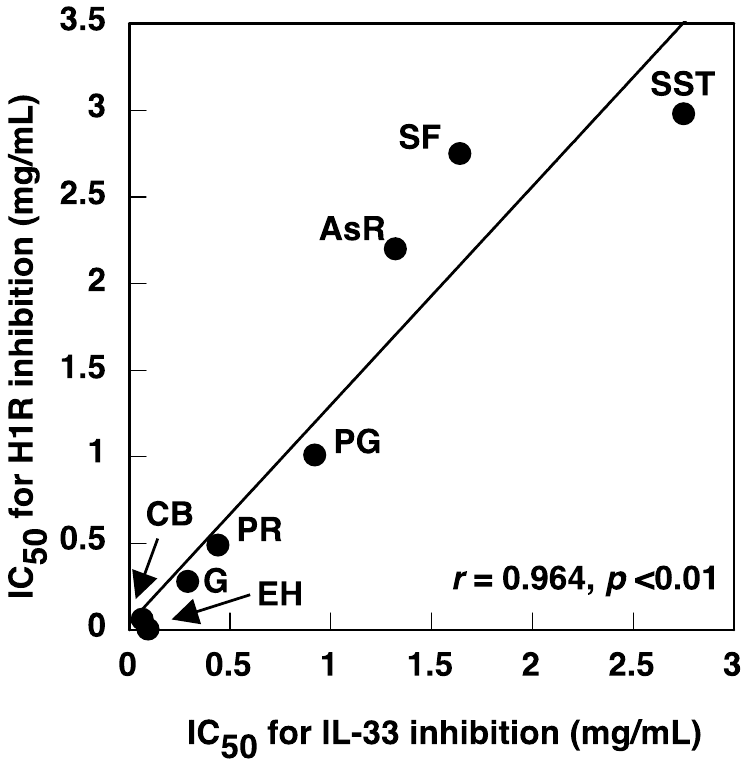
Figure 4. The correlation between IC 50 values of SST and its seven crude drugs to inhibit the IL-33 and H1R gene expression. A Spearman’s rank correlation test was used for the statistical analysis ( r = 0.964, p < 0.01). SST: Syo-seiryu-to; EH: Ephedra herb; CB: cinnamon bark; PG: processed ginger;